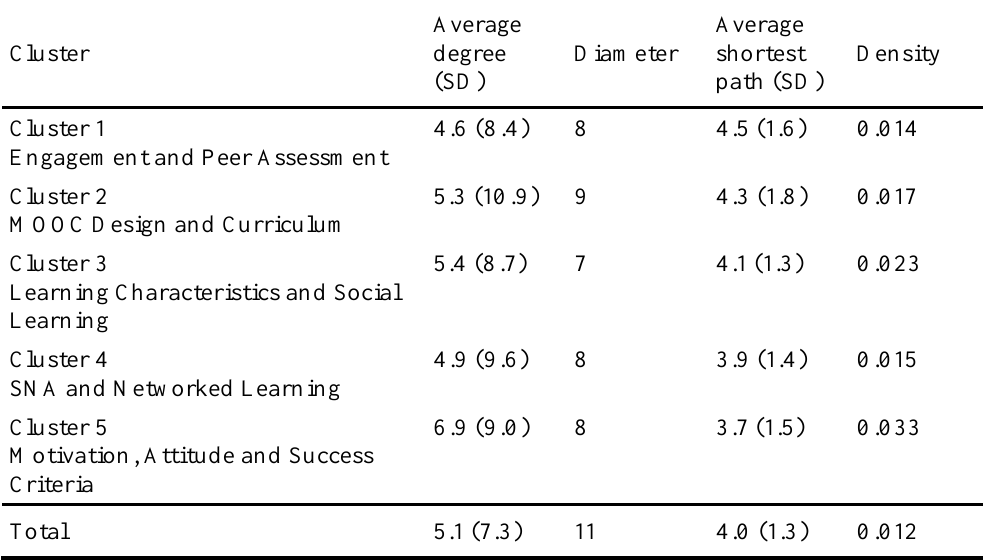
Phase 2 Citation Network